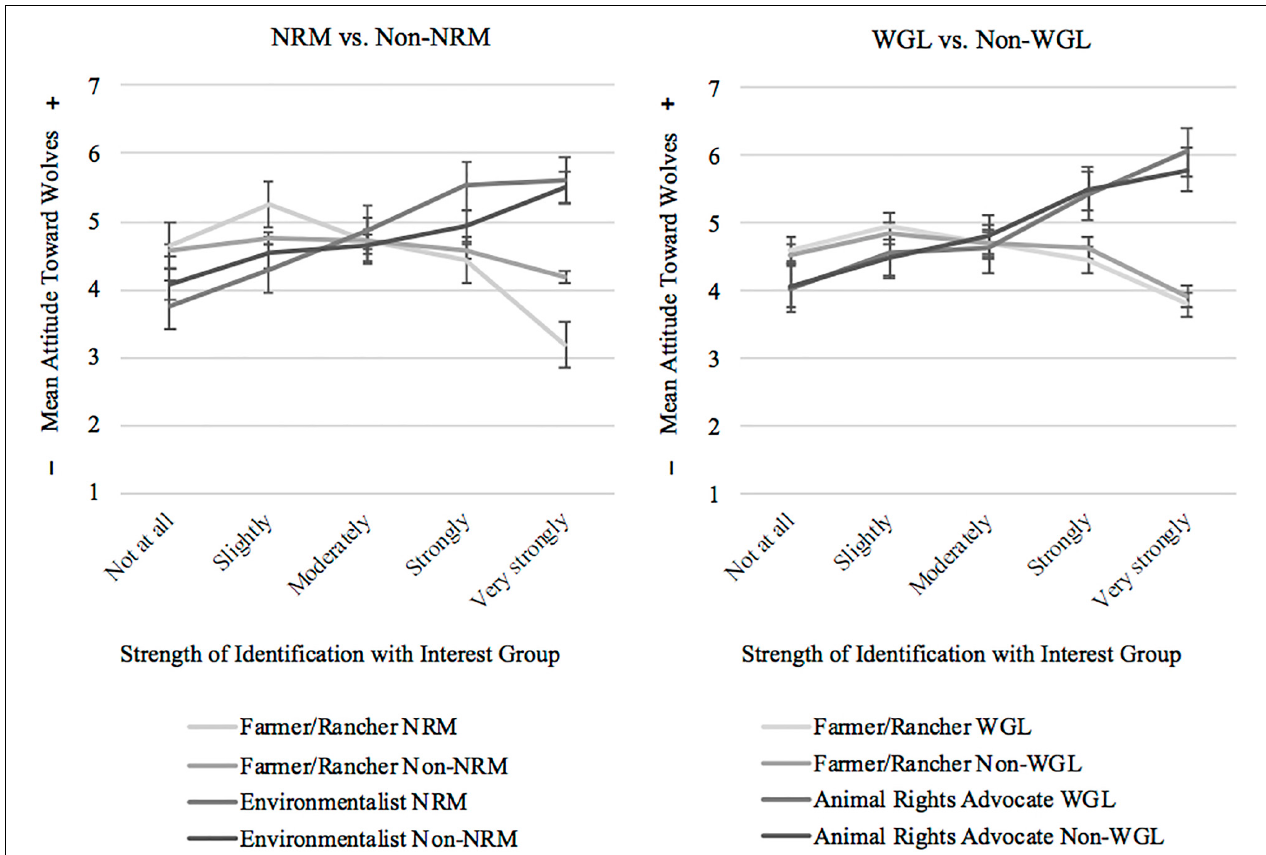
FIGURE 1 | Attitudes toward wolves 1 in the United States by identification with interest groups (2014). 1 Measured on a seven-point scale ranging from one (negative perceptions of wolves) to seven (most favorable perceptions of